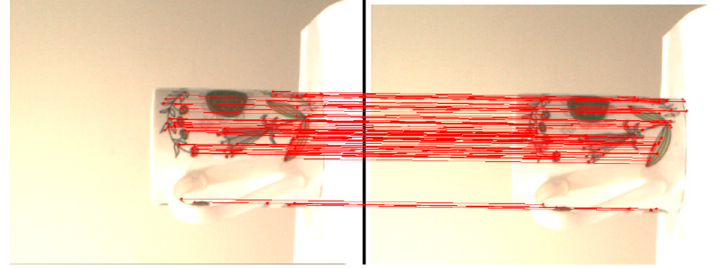
Figure 21. Feature matching results of the original image with the shifted one. When the original image is rotated and skewed, 272 and 235 feature points are derived,